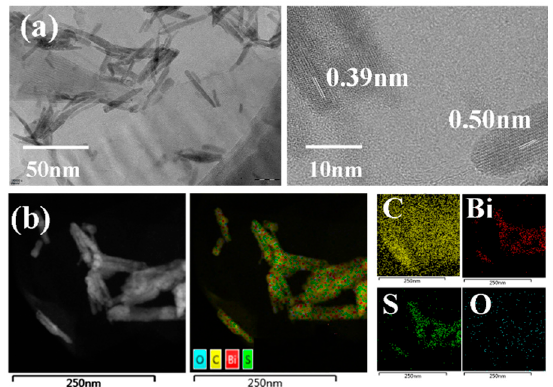
Figure 2. ( a ) TEM and HRTEM images of the GO/Bi 2 S 3 NPs; ( b ) HAADF and EDS mapping.